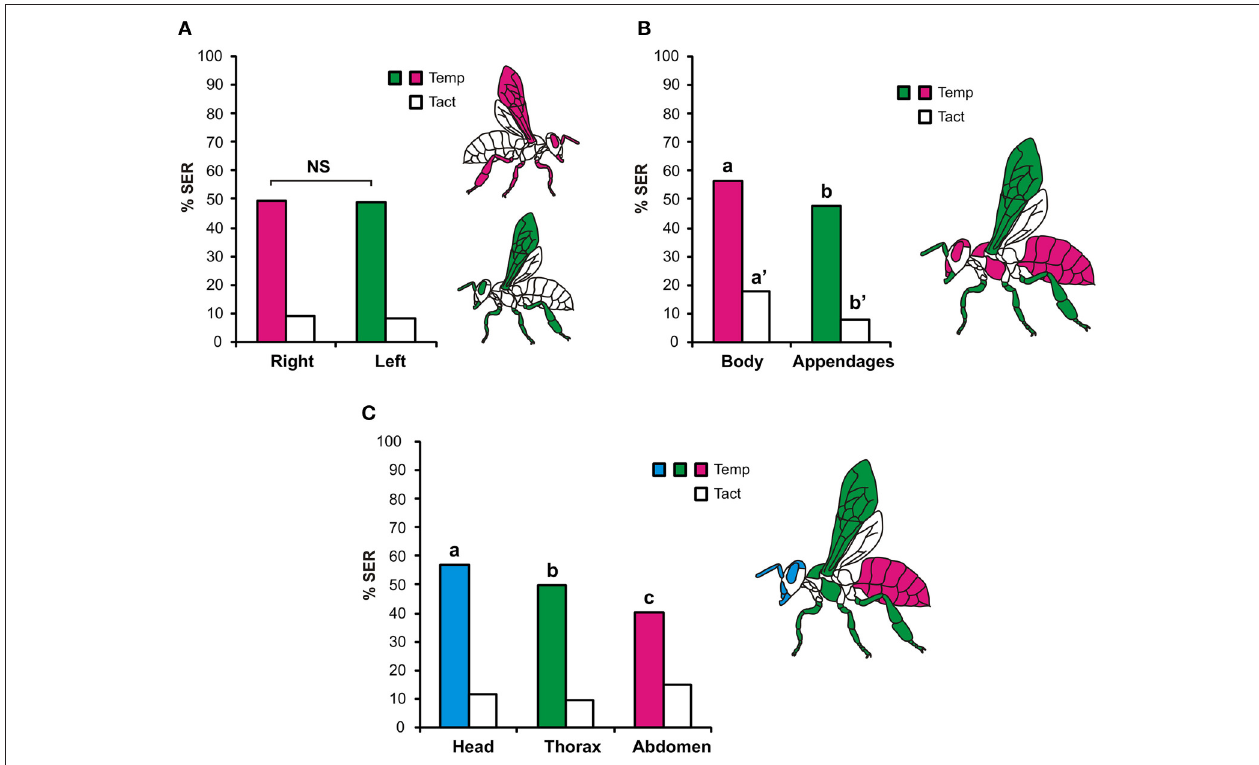
FIGURE 3 | Tactile and heat sensitivity according to the location of the structures. (A) Bilateral symmetry: responses of left (green) or right (magenta) structures were pooled and compared. Stimulations on both sides induced similar SER rates. (B) Body/appendages: data were pooled for all appendages (green: antennae, mouthparts, legs, wings) and for main body parts (magenta). Body structures responded significantly more than appendages to both tactile and heat stimulations. (C) Heat sensitivity according to the antero-posterior axis: data were pooled separately for head (blue), thorax (green), and abdomen (magenta). A gradient of thermal response intensity was found from head to abdomen. Different letters indicate significant differences in Chi 2